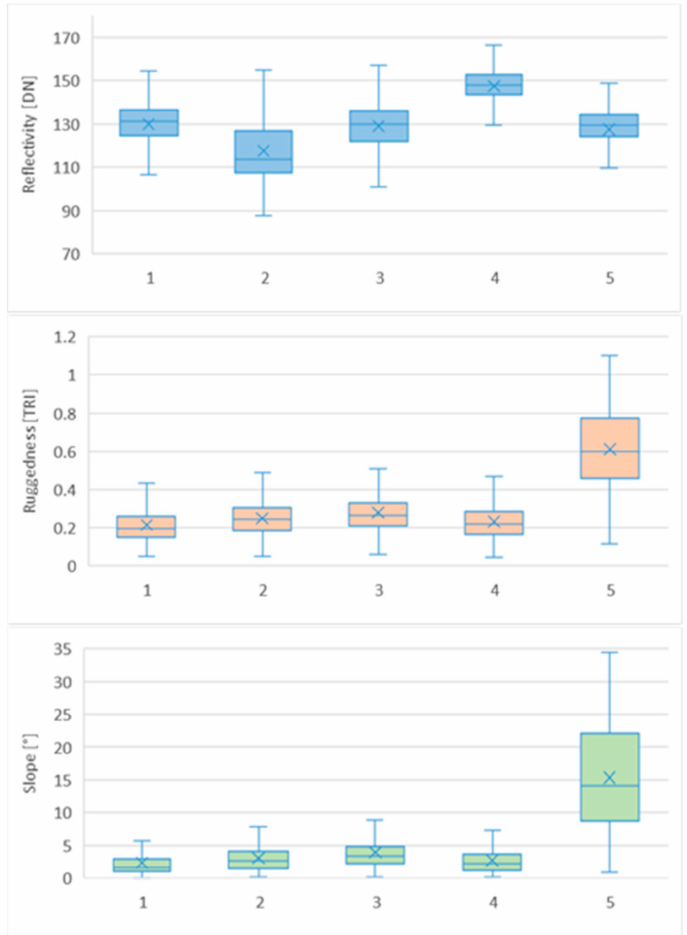
Figure 5. Box-plots for reflectivity, ruggedness, and slope against the five identified clusters. Hori- zontal lines and crosses inside the boxes are the median and the mean values; lower and upper limits of boxes represent the first (Q1) and the third (Q3) quartile; whiskers go from the first quartile to the minimum and from the third quartile to the maximum values of each set.